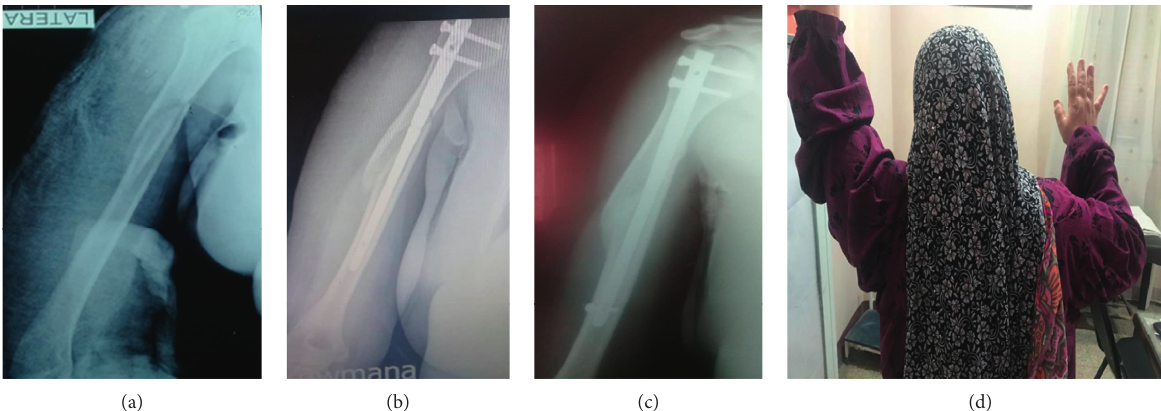
Figure 1: A 48-year-old female had right humeral shaft fracture AO/OTA type 12-A by interlocking nail (b). 8 months after surgery, there was complete bone union (c), but there was limited range of shoulder motion due to impingement and secondary frozen shoulder